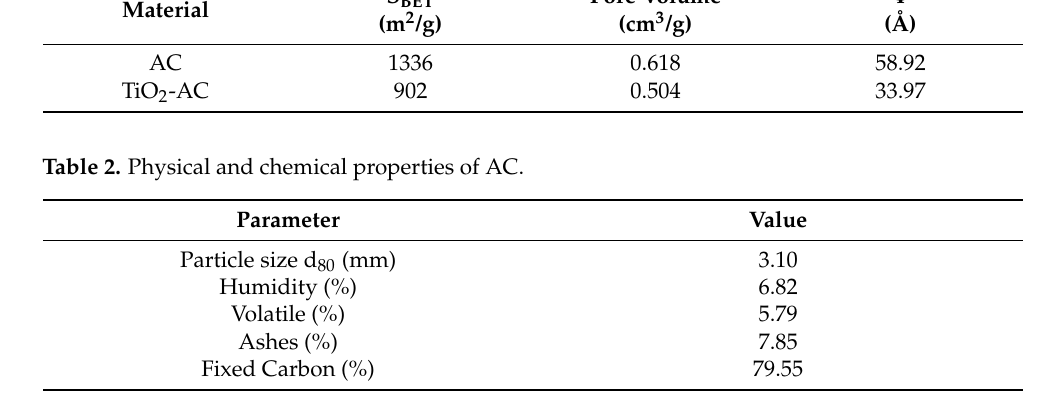
Table 1. Textural properties determined by N 2 physisorption and BET modeling of AC and TiO 2 ‐ AC catalyst.